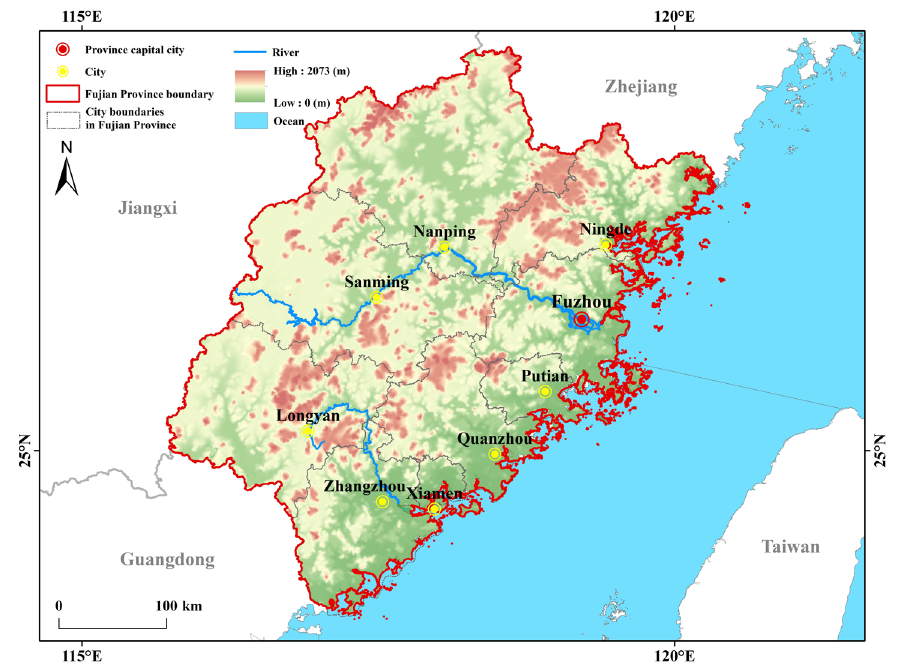
Figure 1. The location and elevation of the Fujian Province, China.